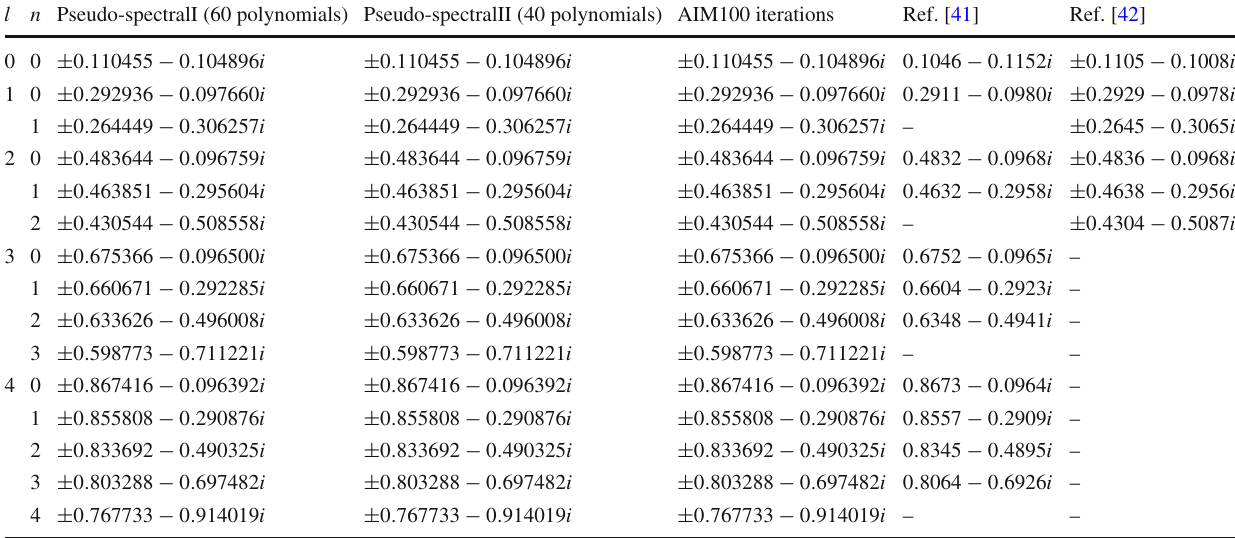
Table 1 Quasinormal frequencies of the spin 0 perturbations normalized by the mass ( M ω) compared against the results of Refs. [41,42] l n Pseudo-spectralI (60 polynomials) Pseudo-spectralII (40 polynomials) AIM100 iterations